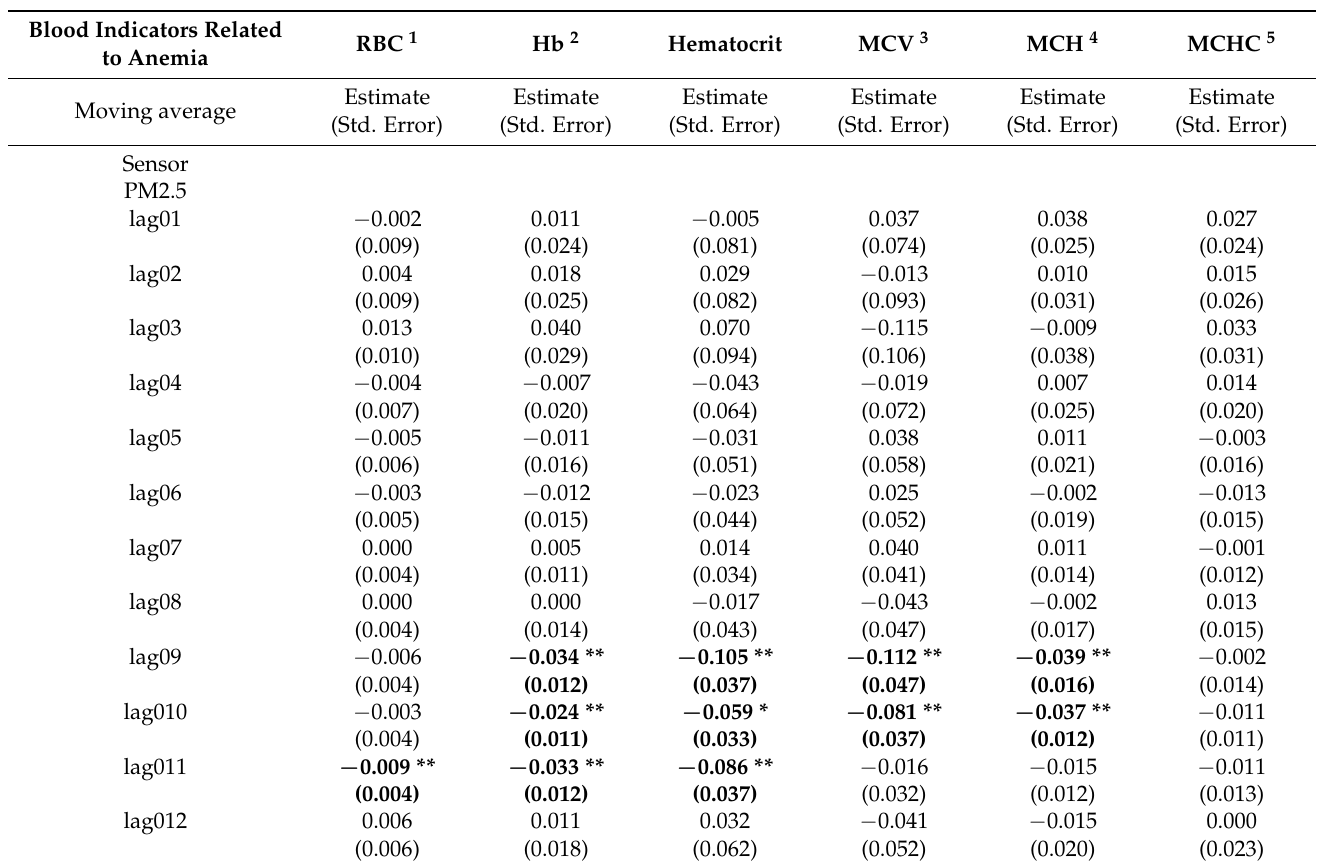
Table 3. Regression model of particulate matter (sensor-long-term exposure) for blood indicators related to anemia. Blood Indicators Related